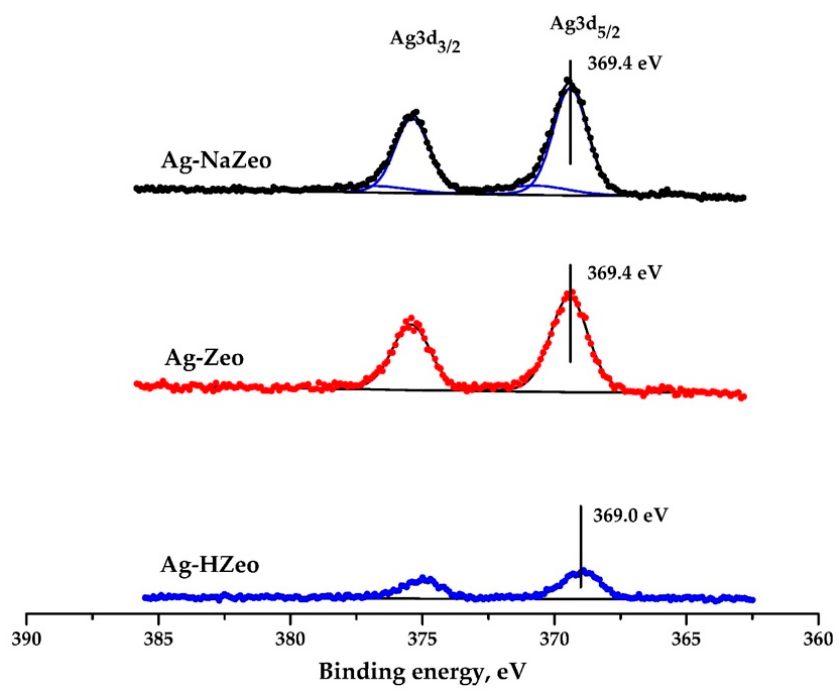
Figure 5. Photoelectron Ag 3d spectra of samples Ag–Zeo, Ag–NaZeo, Ag–HZeo. Table 3. XPS parameters for samples Ag–Zeo, Ag–NaZeo,